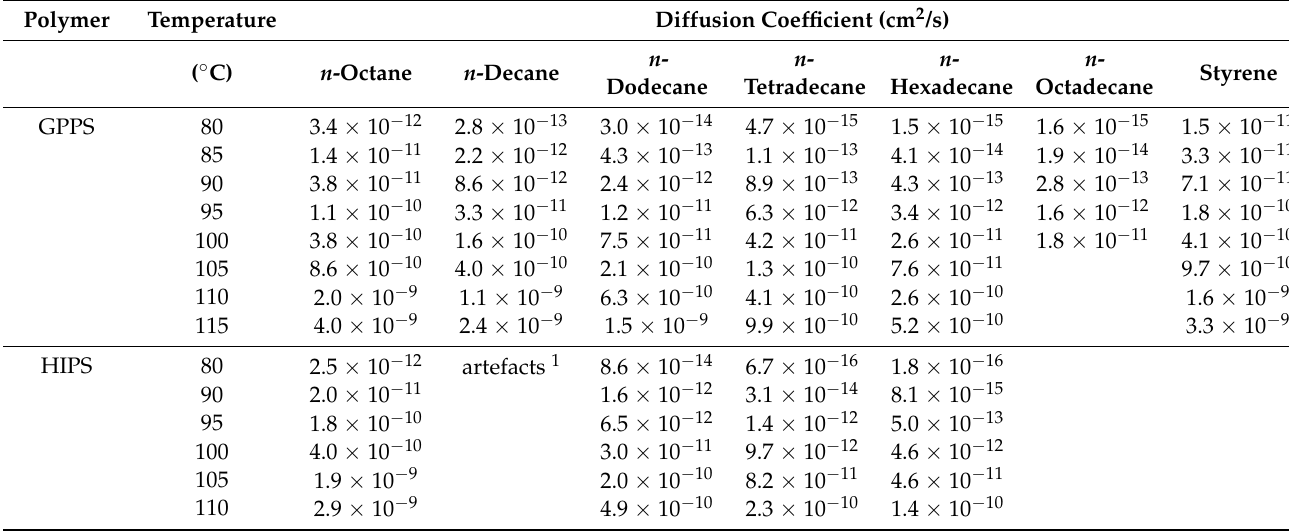
Table 3. Experimentally determined diffusion coefficients of n -alkanes and styrene in polystyrene GPPS and HIPS (sheet 1) from desorption kinetics.